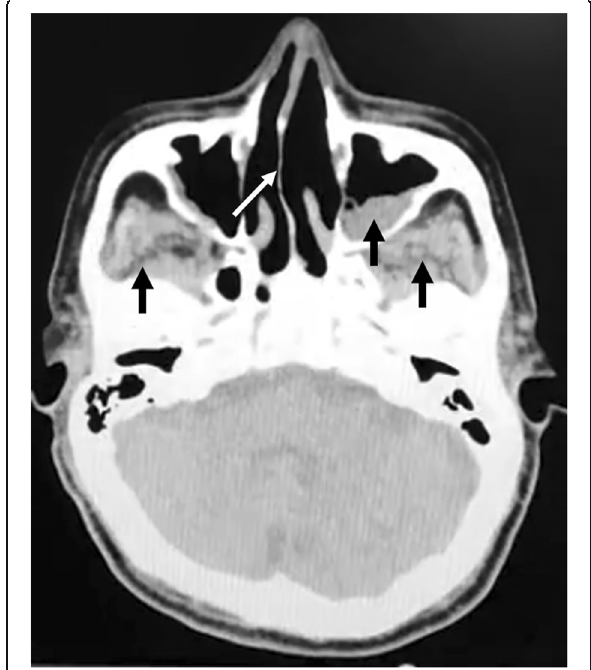
Fig. 5 Paranasal sinuses CT. Pansinusitis (black arrows) with a right deviation of the nasal septum (white